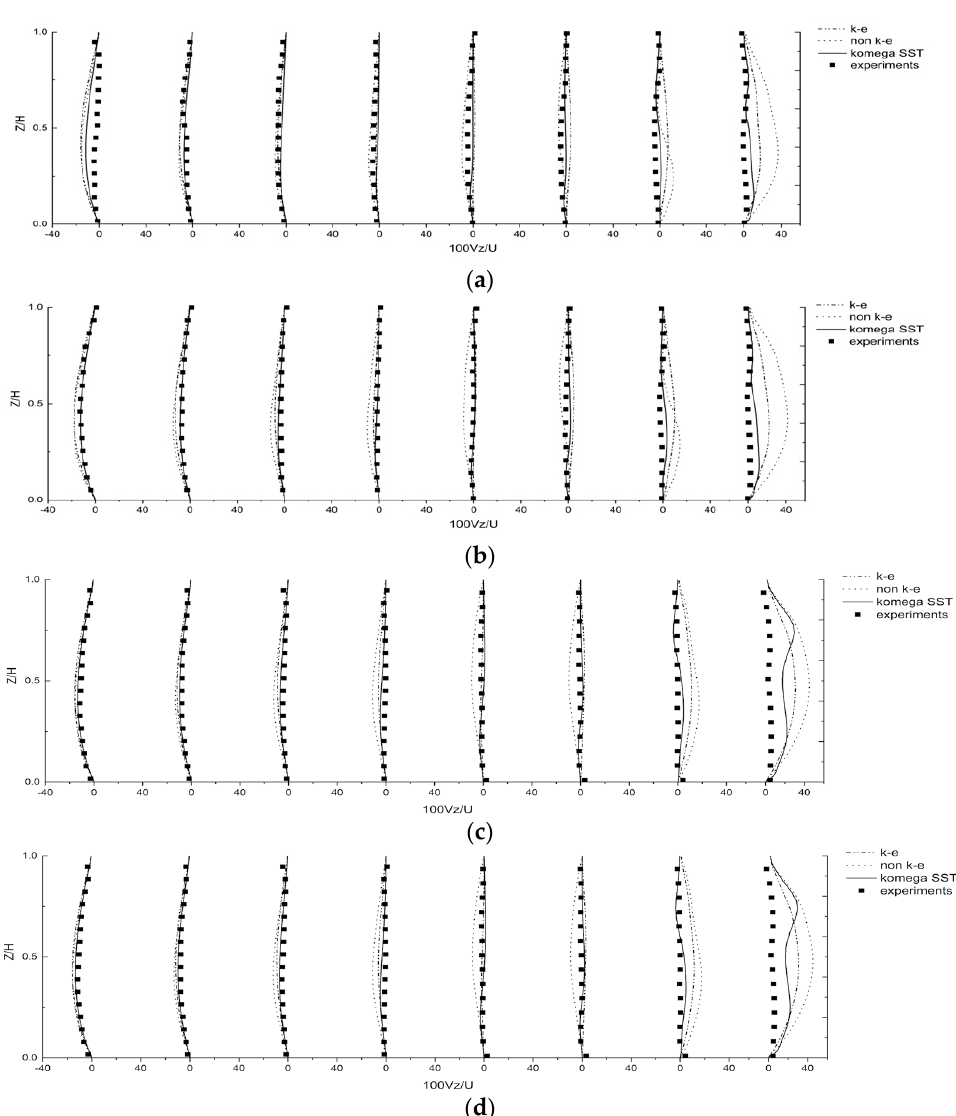
Figure 5. Distribution of vertical component of velocity at 90 degrees with different jet conditions: ( a ) no jet, ( b ) S =3.5 ( c ) S =10 and ( d ) S = 16.5. From the left to the right is the outer bank to the inner ( a ) no jet, ( b ) S = 3.5 ( c ) S = 10 and ( d ) S = 16.5. From the left to the right is the outer bank to the bank. inner